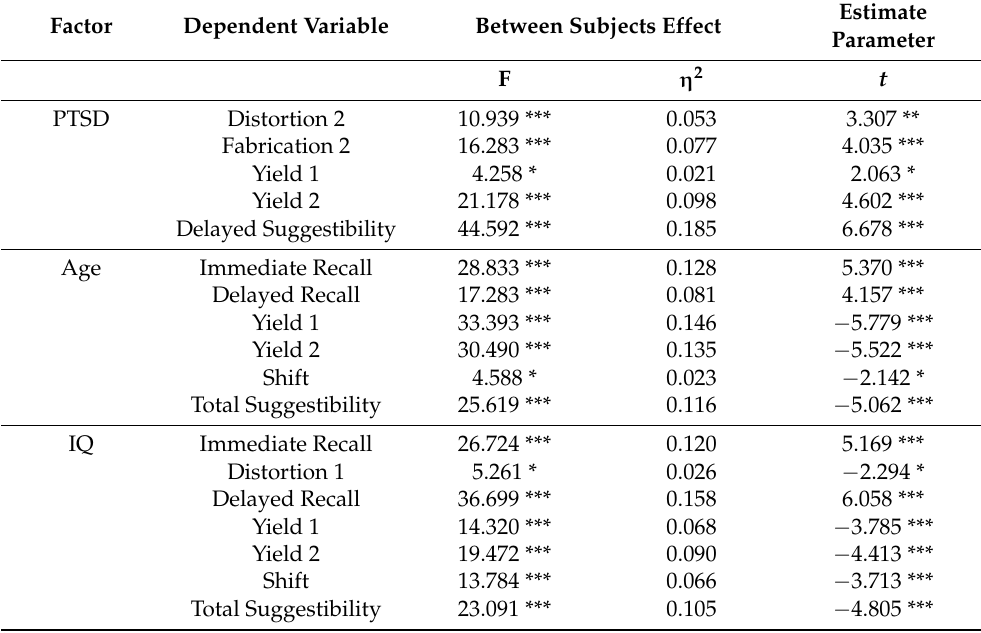
Table 2. Between subjects effects of multivariate analysis of variance (MANOVA) for GSS2, PTSD, age, and IQ ( n = 221). Estimate Factor Dependent Variable Between Subjects Effect Parameter F η 2 t PTSD Distortion 2 10.939 *** 0.053 3.307 ** Fabrication 2 16.283 *** Yield 1 Delayed Suggestibility Age Delayed